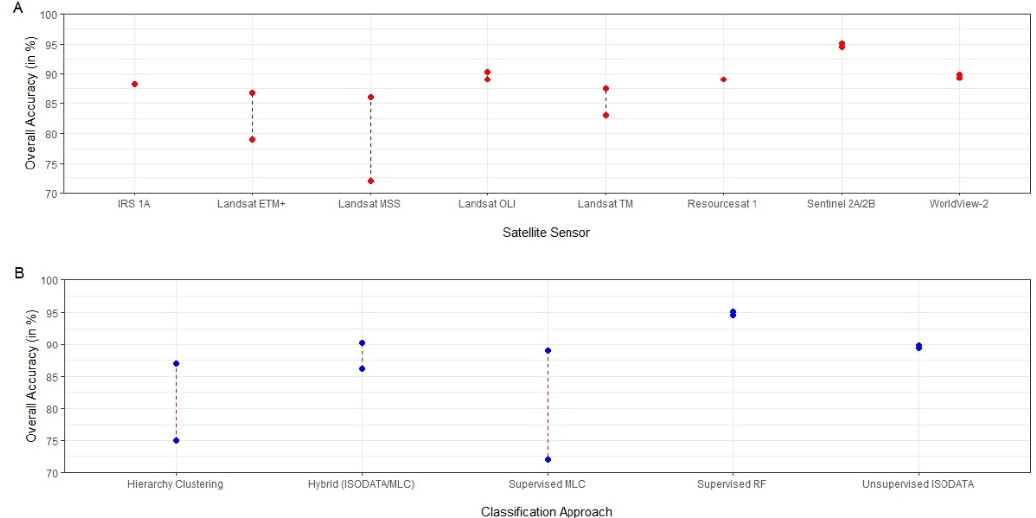
Figure 6. Range of overall classification accuracy in forest related studies based on satellite sensor ( A ) and classification approach (B).